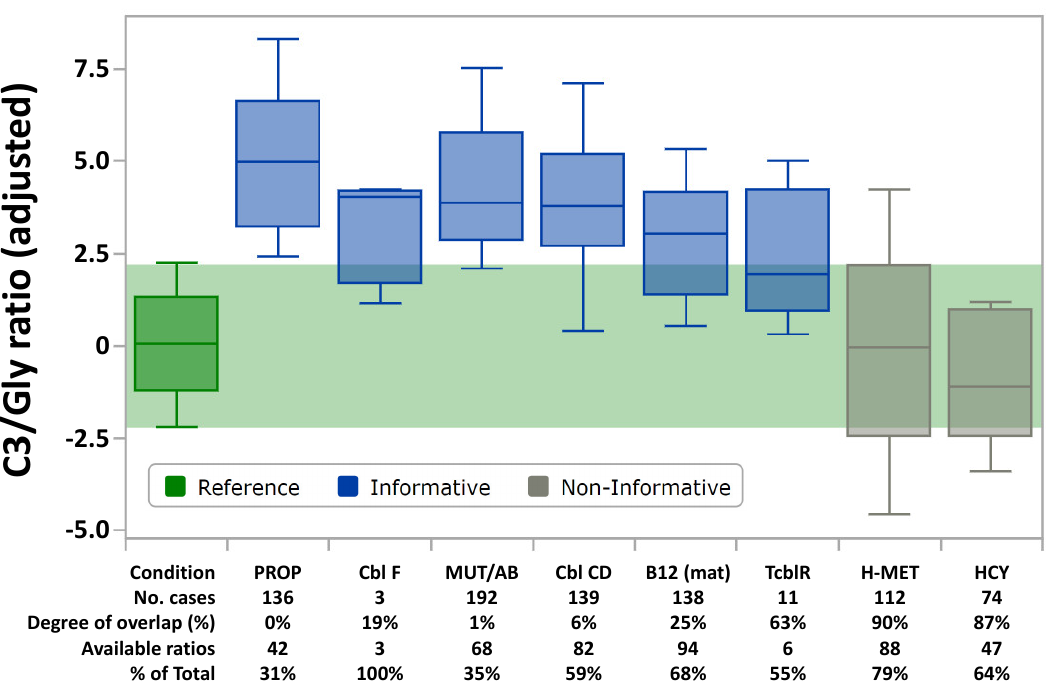
Figure 1. CLIR productivity tool “Plot by Marker” for C3 / glycine ratio. Box and whisker plots display the 99%, 90%, 50%, 10%, and 1% percentiles, respectively. The horizontal green band overlays the reference percentiles (dark green, n = 1,368,748) with the individual disease ranges. Ranges are shown as Multiple of the Median after simultaneous adjustment for age (hours), birth weight (grams), and location ( n = 50), expressed as Z-scores. Condition codes are the same as shown in Table